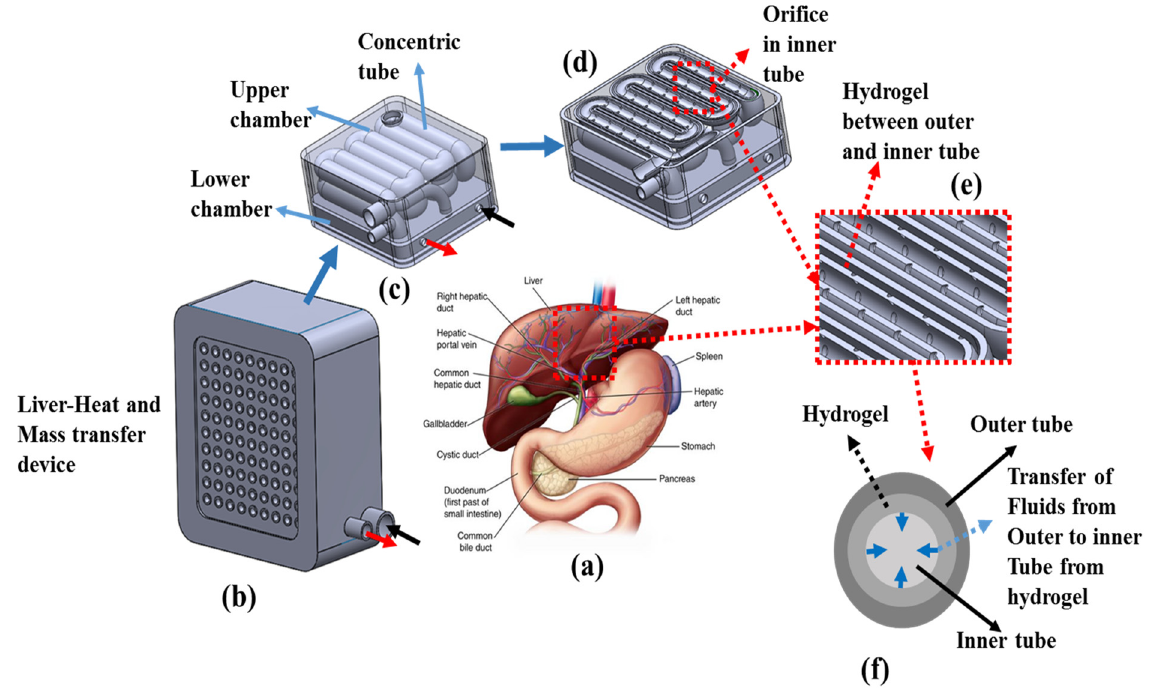
Figure 1. Schematics of the device design evolution. ( a ) Sketch details of the human liver with blood sources and glands, ( b ) 3D model of the actual additive manufactured device, with a fluid inlet and outlet, comprising concentric tubes, ( c ) the internal sections of the device, with a concentric tube in the upper section and lower section for the inlet and outlet of the device, ( d ) sliced portion of the concentric tube showing the orifice in the inner tube, ( e ) detailed section, highlighting the hydrogel between the outer and inner tube, and ( f ) the cross-section of the concentric tube where the mass transfer occurs, from the outer to inner tube.